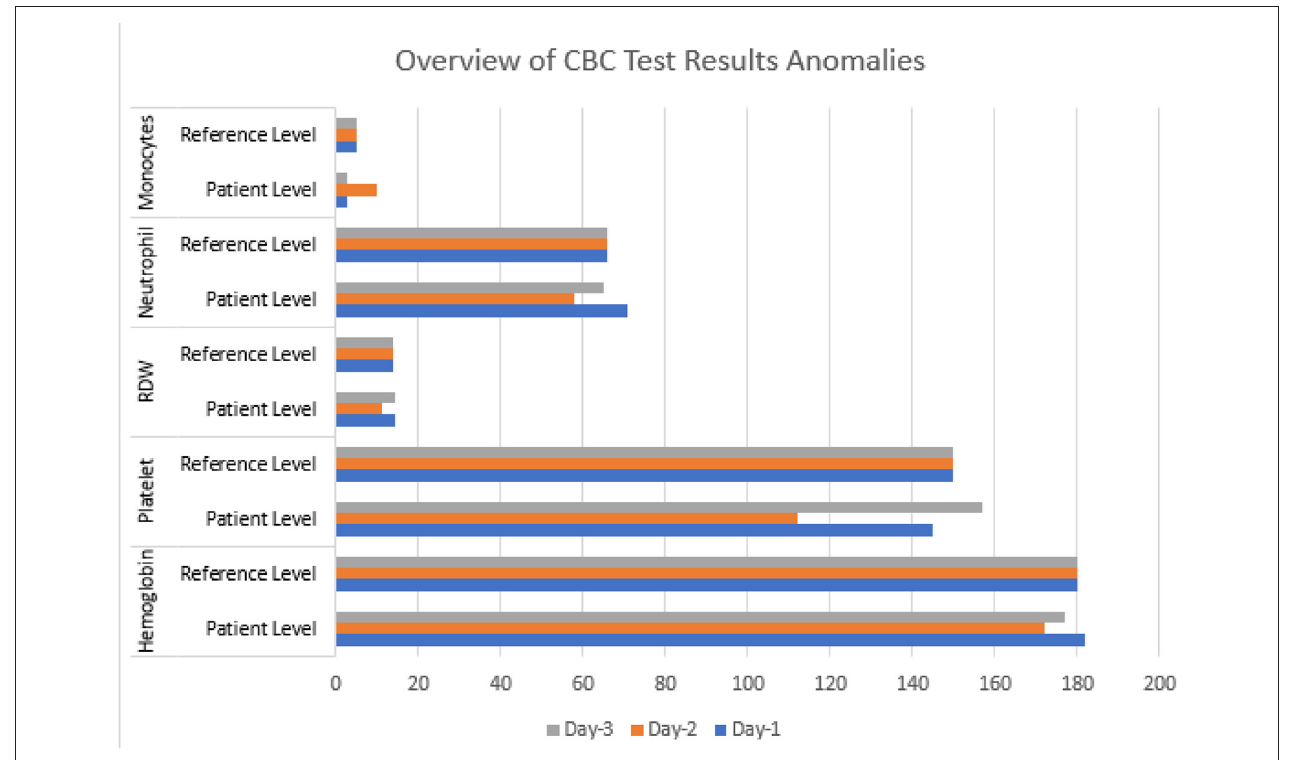
FIGURE 1 | Chart summary of the three CBC test results showing anomalies alongside reference